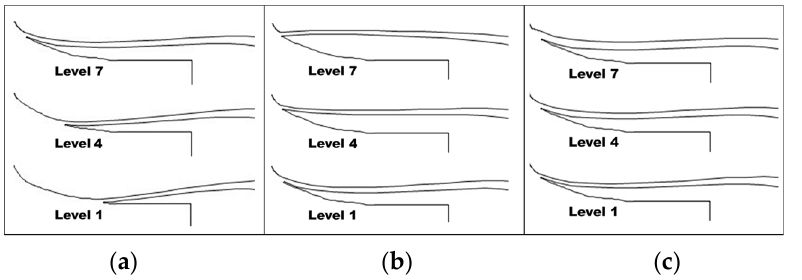
Figure 7. Examples of different instances of model 1 variables. ( a ) Length; ( b ) Angle; ( c ) Height.